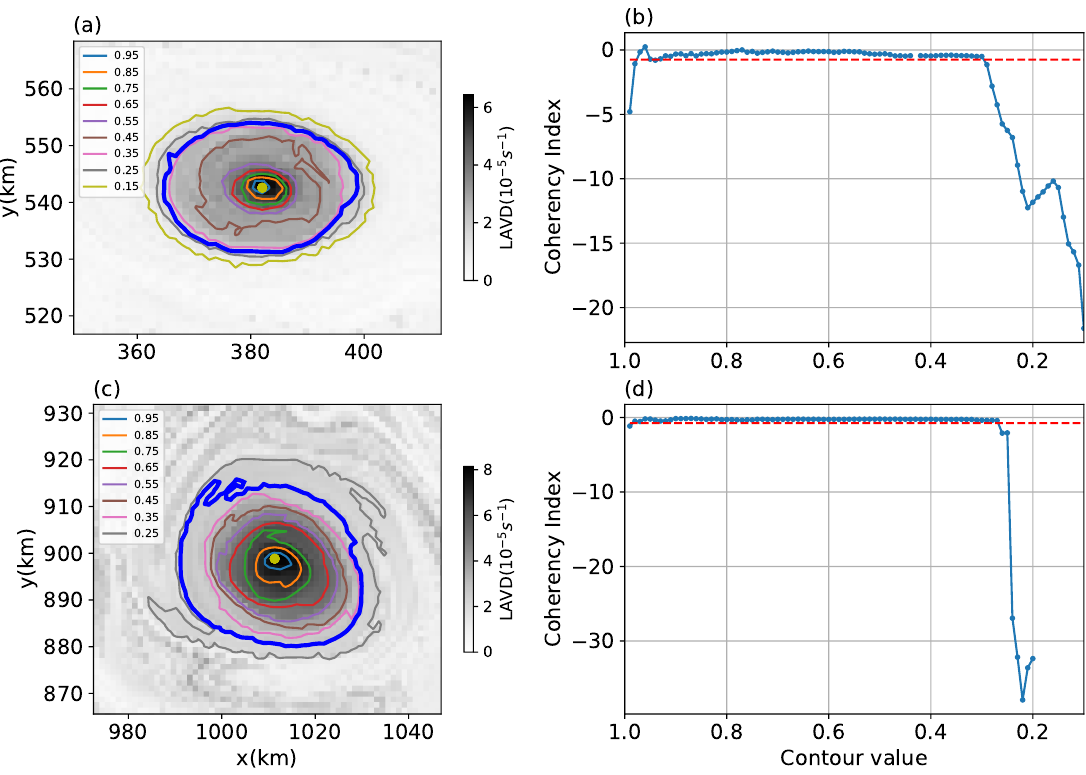
Figure 2. ( a , c ): Lagrangian averaged vorticity deviation (LAVD) fields at the initial particle positions for two example eddies (shading). Contours give values relative to the LAVD maximum at the eddy center with the outer boundary obtained from the threshold Coherency Index (CI) > − 0.75 indicated by a thick blue contour. ( b , d ): Radial distribution of the CI for the eddies shown in ( a , c ), respectively, as a function of contour. Dashed red lines indicate the threshold value for the